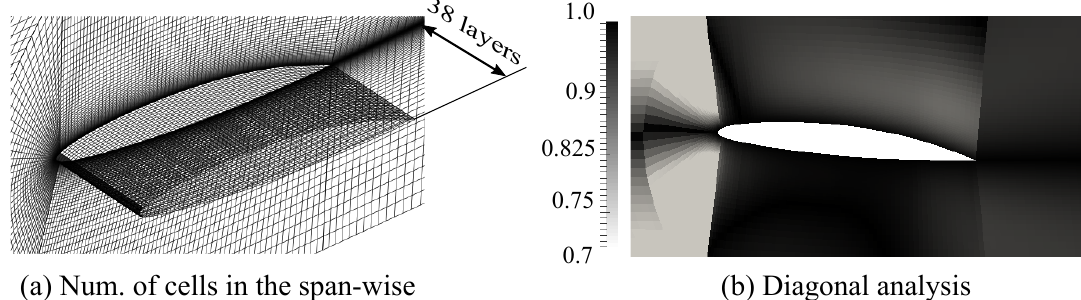
Figure 2. Structured grid mesh around a